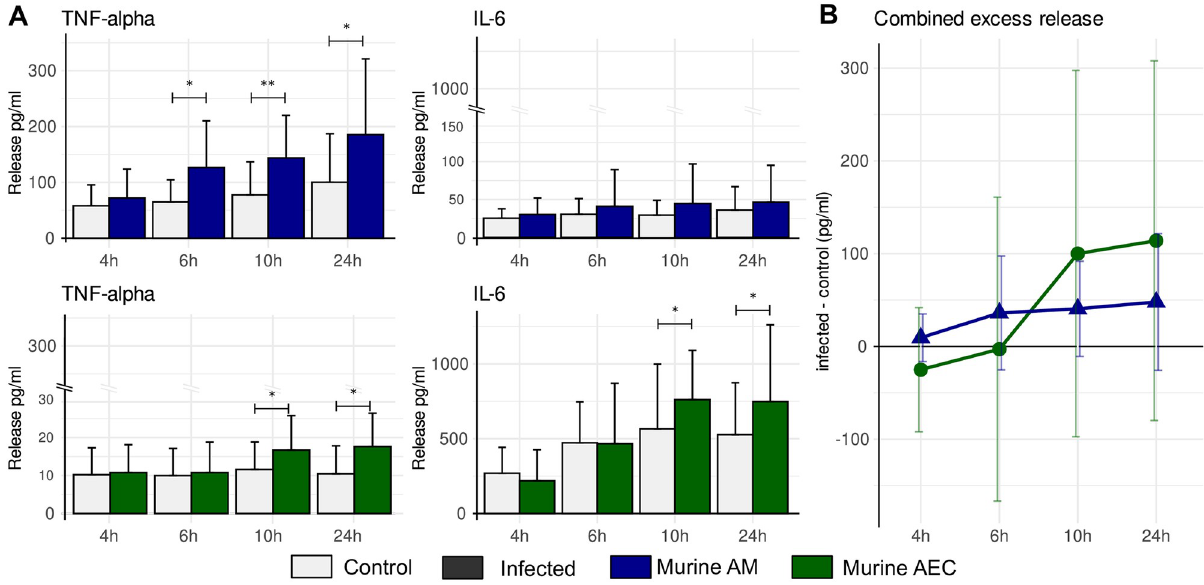
Fig 6. Ex vivo cytokine release of isolated murine alveolar macrophages (AM, blue) and epithelial cells (AEC, green) upon infection with A. fumigatus . A Release of (TNF)- α and (IL)-6 over time in infected and control cells measured by ELISA. Significant differences between control and infected cells were determined by a two-tailed and paired t-test indicated by � ( p < 0.05) and �� ( p < 0.01). Error bars represent the standard deviation from nine mice used for cell isolation. B Combined cytokine release of both (TNF)- α and (IL)-6 in excess over spontaneous release over time to depict contribution during early and later stages of fungal infection.